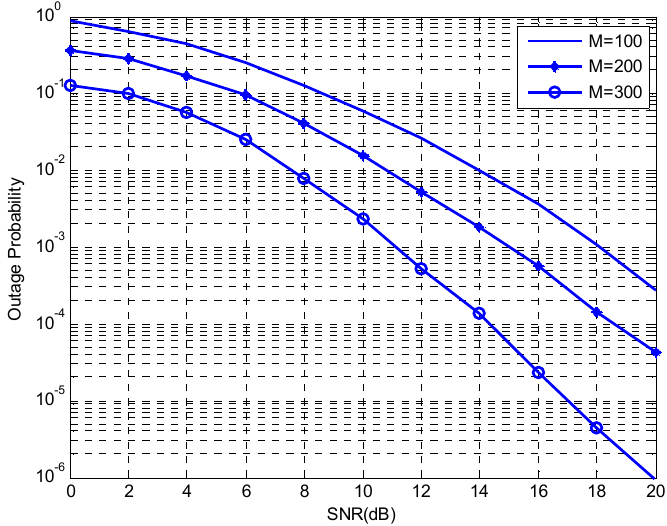
Figure 8. Outage probability vs. signal to noise ratio (dB) in multi-cell system with Υ (cid:96) th = 10 dB, K = 10 and L = 7.